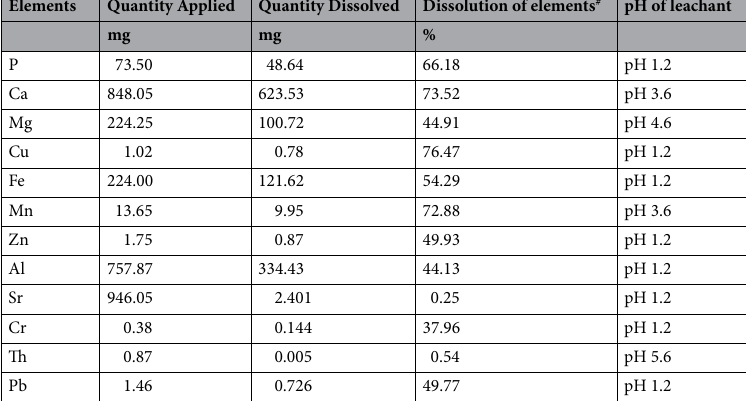
Table 3. Amount of PG organic applied, and percentage dissolved at the end of leaching. # D = QD/QA × 100%, where: D = % of element dissolved, QD = quantity dissolved, QA = quantity applied; QD = cumulative quantity dissolved at day 30 in amended column minus the cumulative quantity dissolved at day 30 in control expressed in mg; QA = calculated total amount of elements in the PG organic applied to each column expressed in